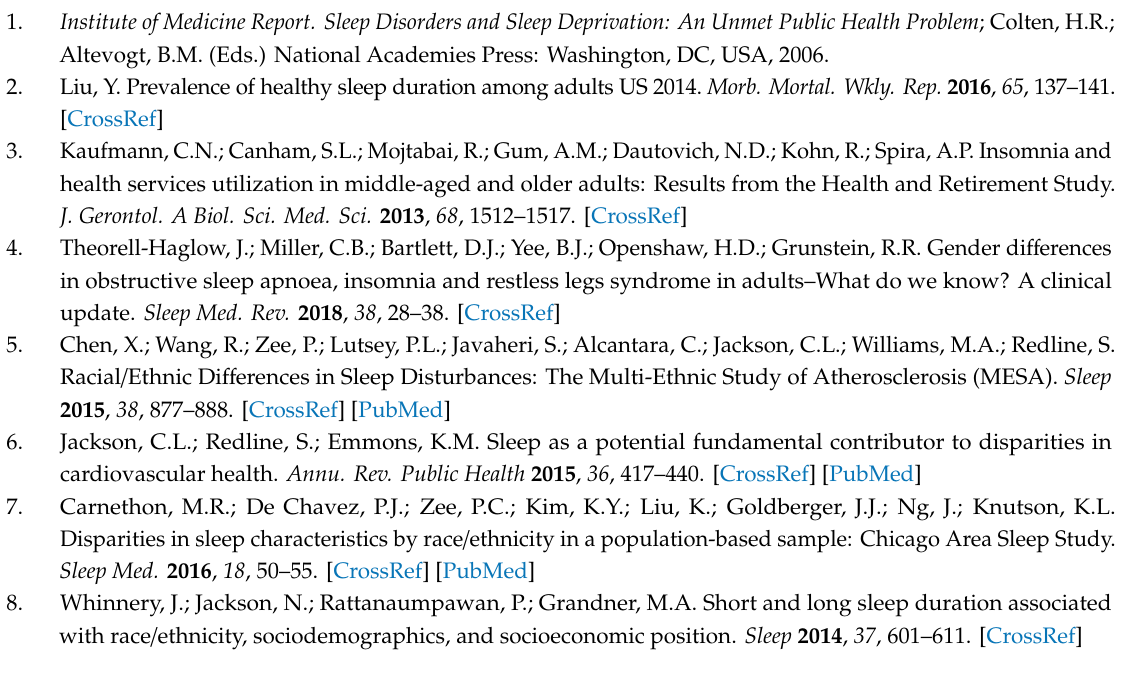
Figure S1: Flow Chart of Participant Selection, Table S1: Age-standardized Sociodemographic, Health Behavior, and Clinical Characteristics between Low, Medium, and High Neighborhood Social Cohesion Among 18–30, 31–49, and ≥ 50 years old, National Health Interview Survey, 2013–2018 (N = 167,153), Table S2: Age-standardized Sociodemographic, Health Behavior, and Clinical Characteristics between Low, Medium, and High Neighborhood Social Cohesion Among Women and Men, National Health Interview Survey, 2013–2018, Table S3: Age-standardized Sociodemographic, Health Behavior, and Clinical Characteristics between Low, Medium, and High Neighborhood Social Cohesion Among Racial / Ethnic Groups, National Health Interview Survey, 2013–2018, Table S4: Age-standardized Sociodemographic between Neighborhood Social Cohesion Scale, National Health Interview Survey, 2013–2018 (N =